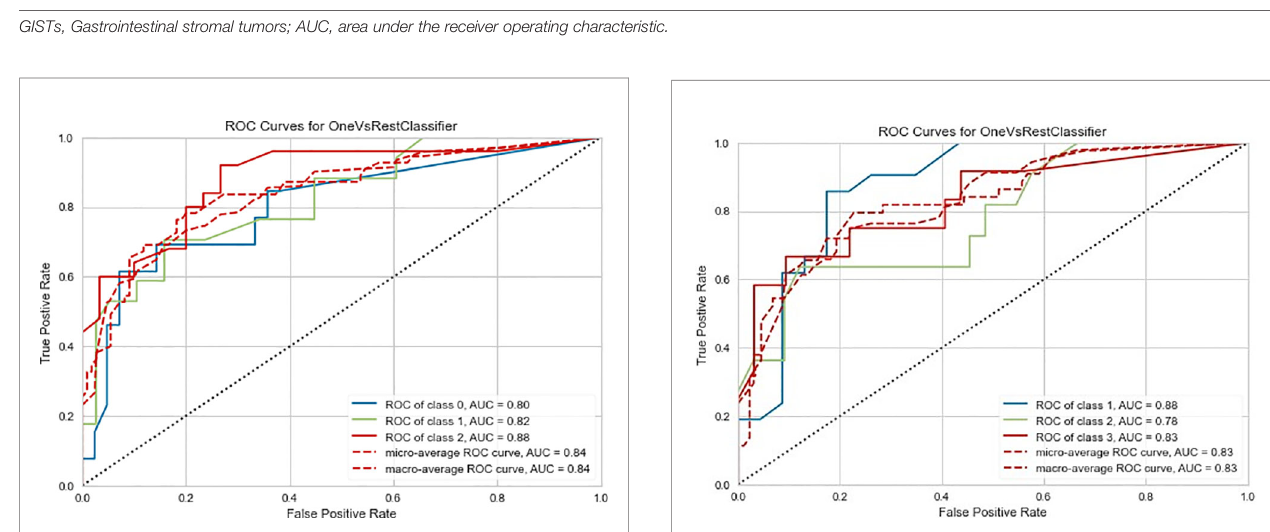
FIGURE 3 | Three-class (one- vs -rest) Receiver operating characteristic (ROC) curve of the training cohort of the radiomics prediction model. Class 0 is the very low- and low-risk group, class 1 is the intermediate-risk group, and class 2 is the high-risk group. The two dashed lines respectively show the ROC curves of micro-average and macro-average, indicating the overall distinguishing ability of the three-class classi fi